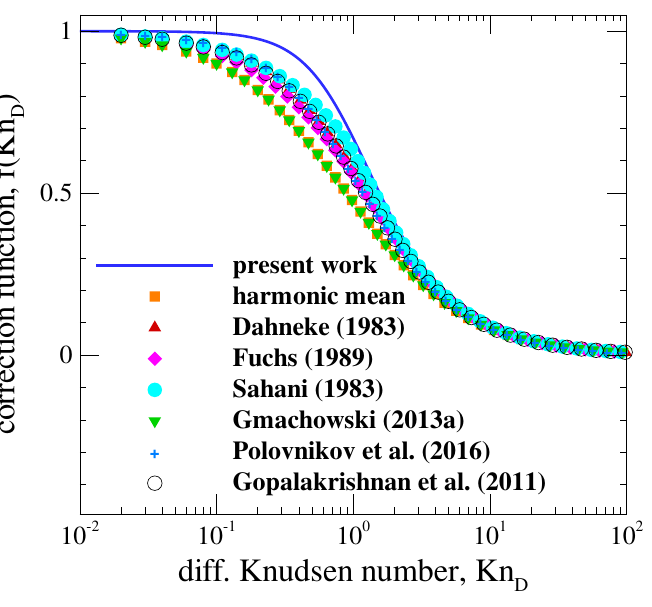
Figure 3. Coagulation kernel correction function f ( Kn D ) as a function of the diffusive Knudsen number Kn D . The proposed model, given by Equation (20) is compared with the literature. Fuchs (1989) [8], Dahneke (1983) [9], Sahni (1983) [10], Gopalakrishnan et al. (2011) [12], Polovnikov et al. (2016) [13], Gmachowski (2013a)